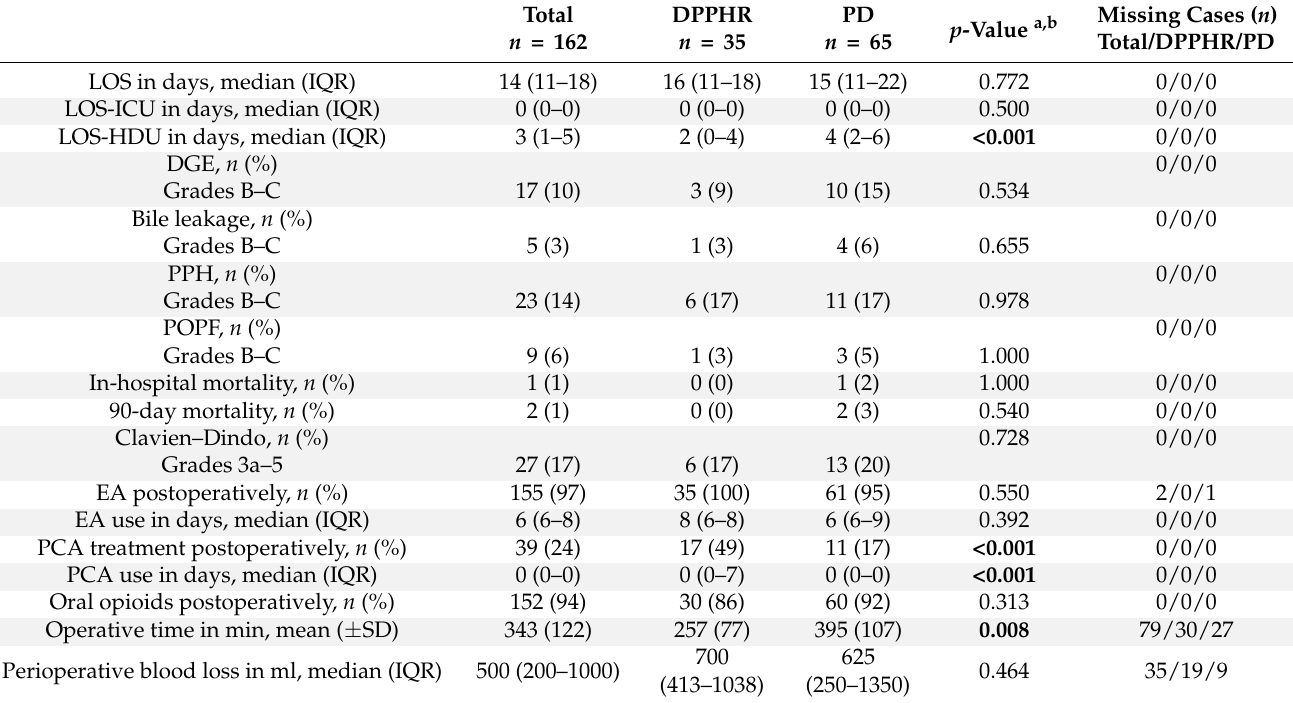
Table 2. Short-term postoperative outcomes.